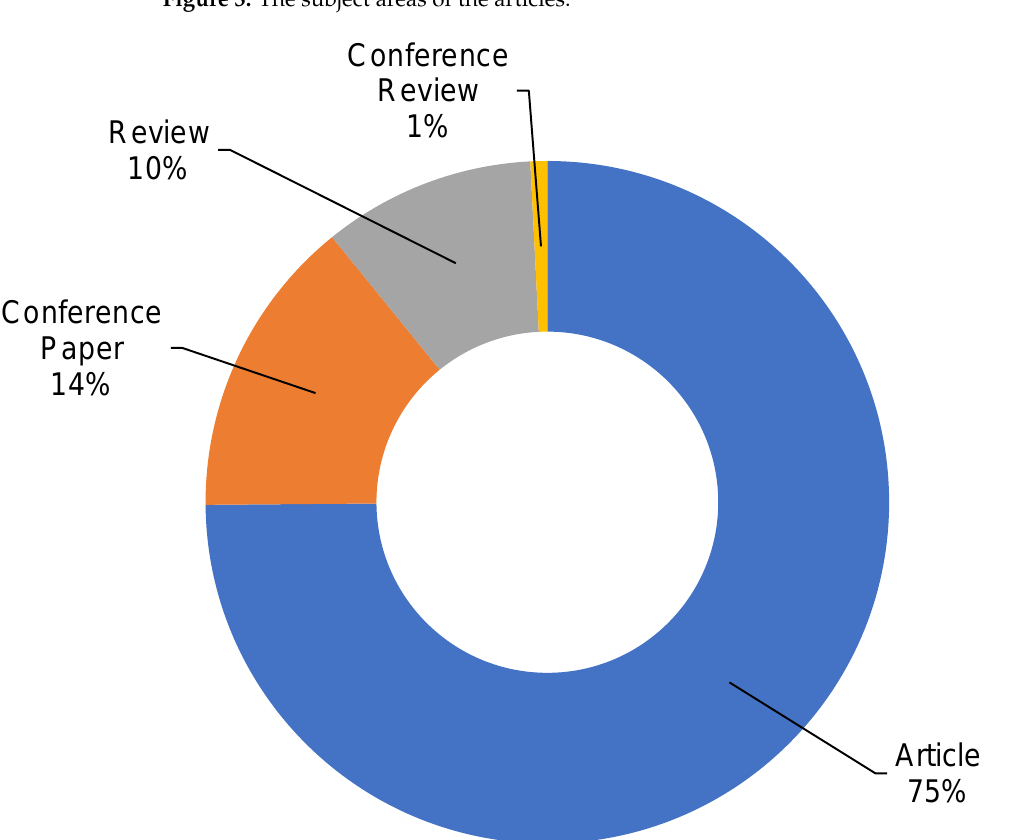
Figure 3. The subject areas of the articles.